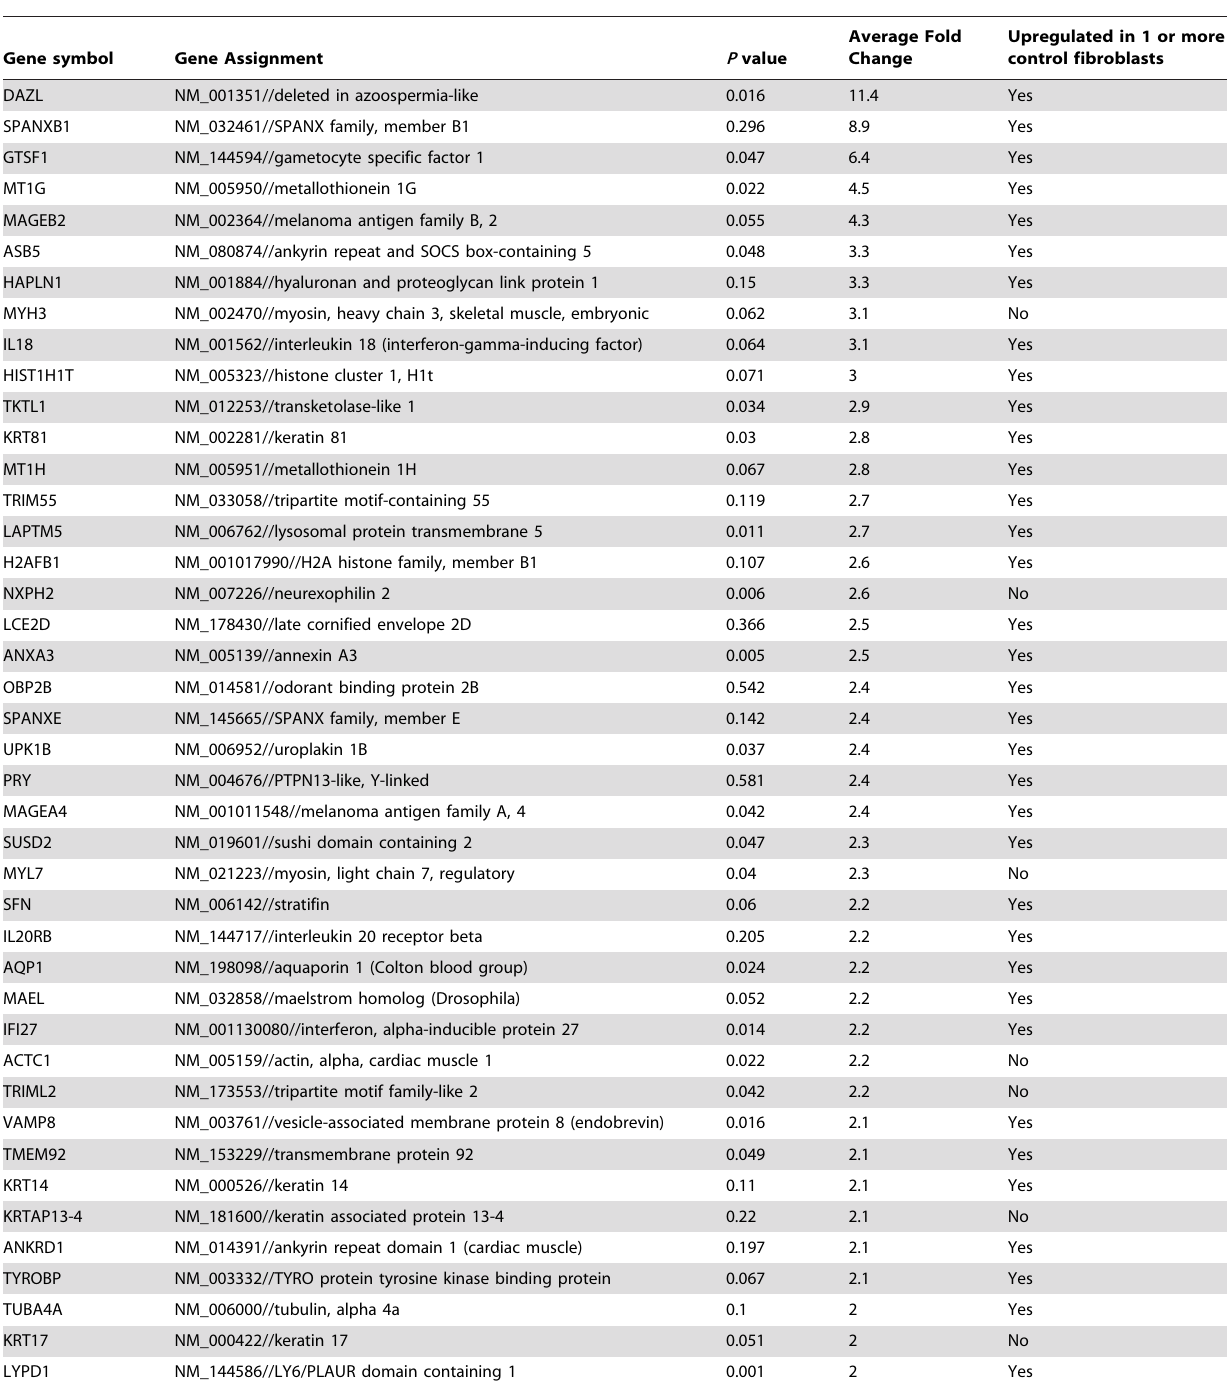
Table 1. Genes upregulated by an overall fold change of $ 2.0 in ten 5-aza-dC-treated pancreatic CAFs relative to untreated CAFs.